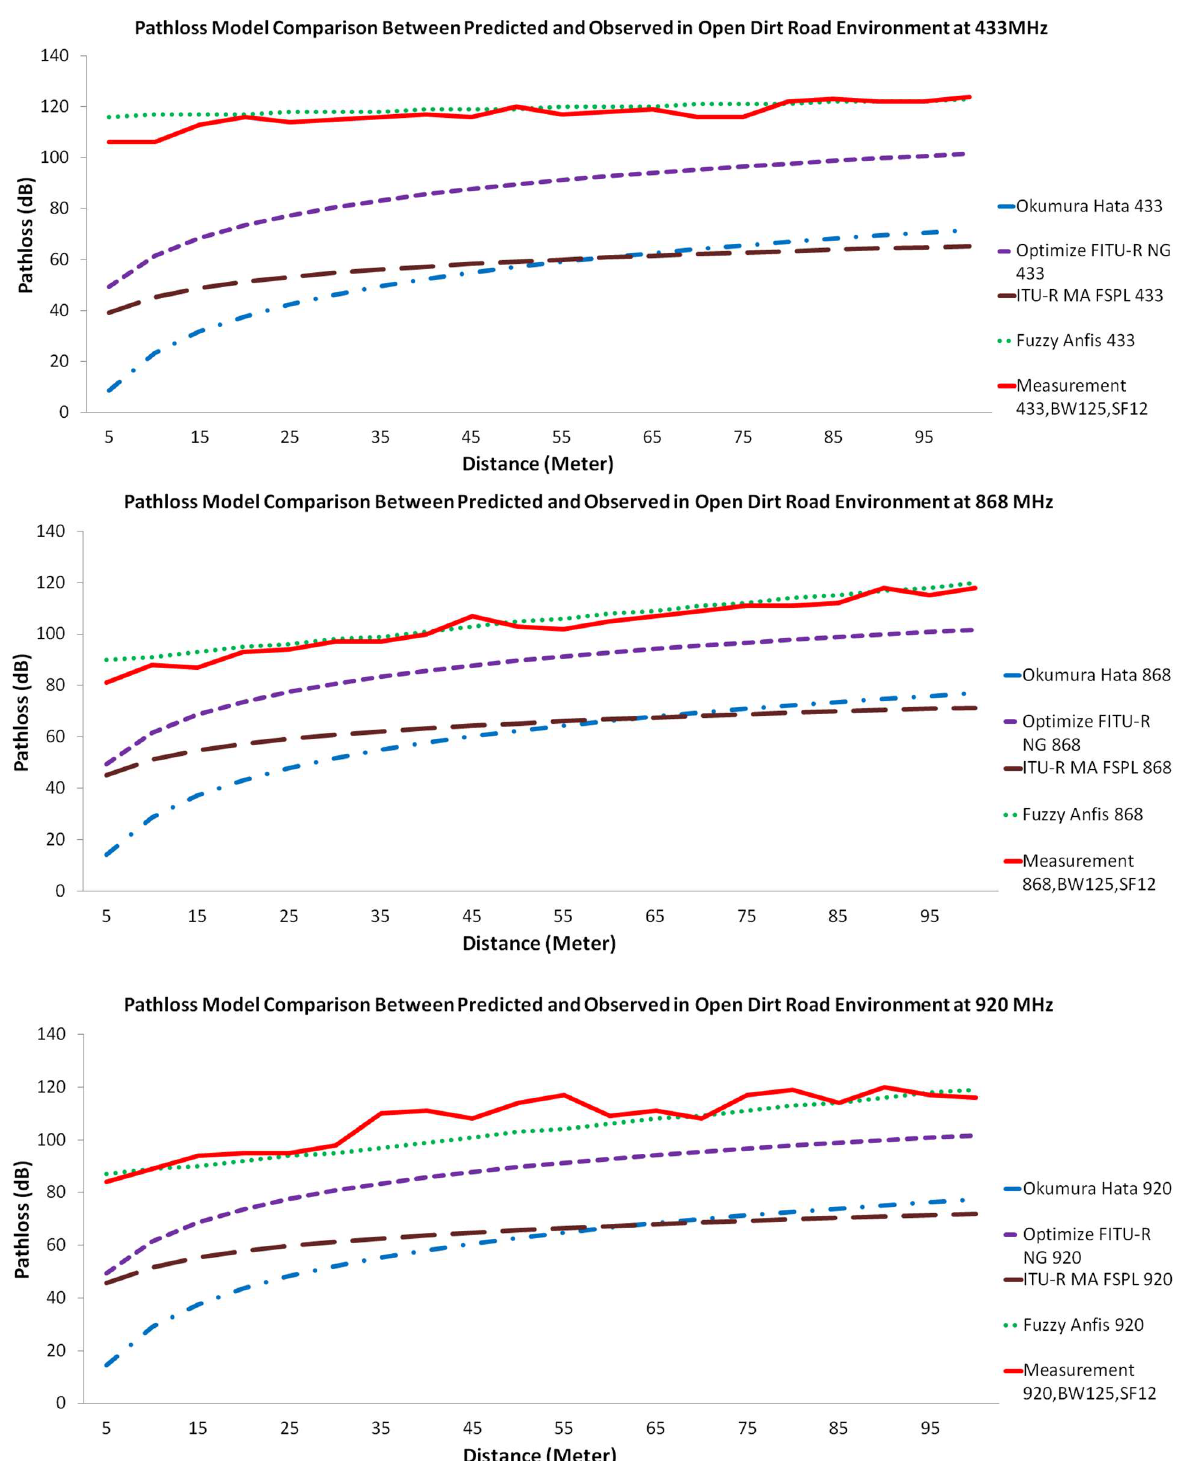
Figure 5. Pathloss model comparison between predicted and observed value in jungle environment for frequency carrier ( top ) 433 MHz, ( middle ) 868 MHz, and ( bottom ) 920 MHz.